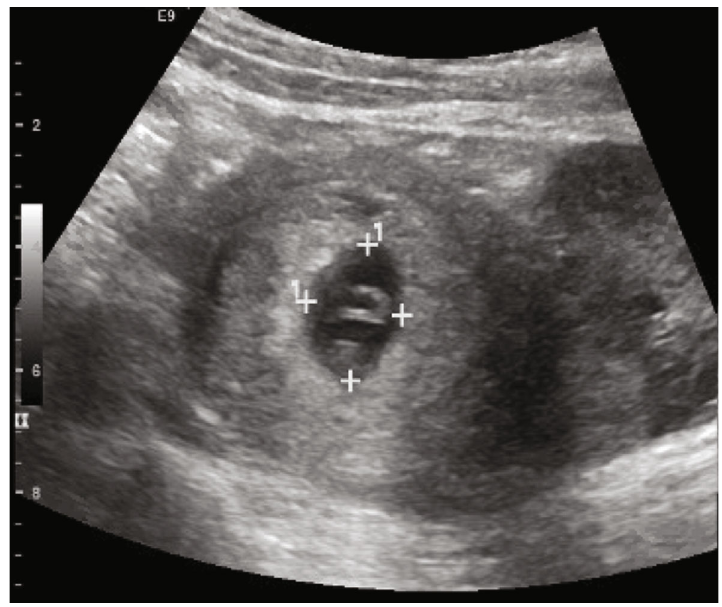
Figure 1: Intrauterine pregnancy with crown rump length 0.98cm consistent with 7 weeks and 0 days of gestation.